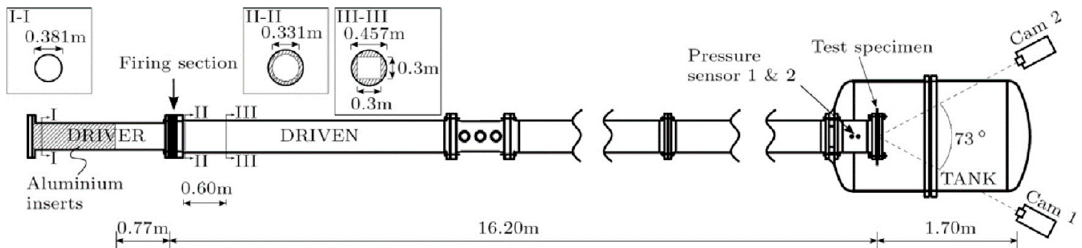
Figure 5. Overview of SIMLab Shock Tube Facility (SSTF) [26].